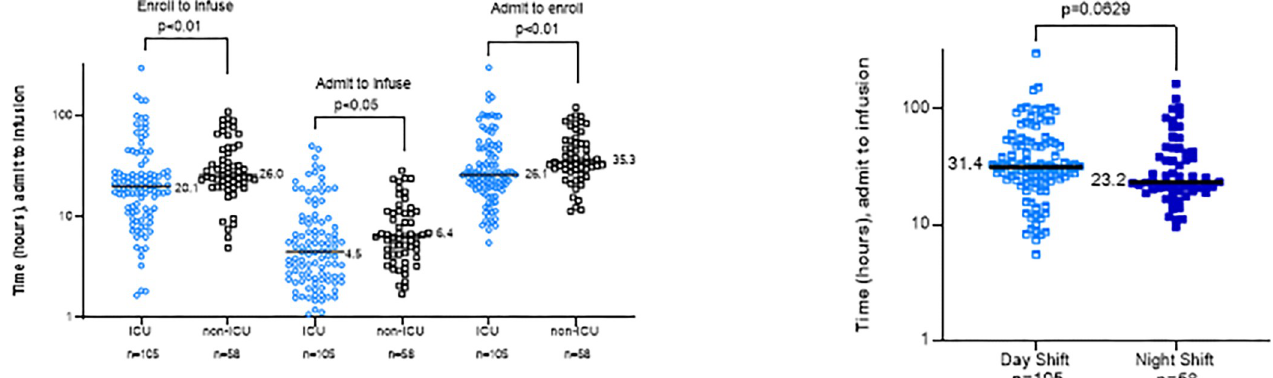
Fig 3. Time to CCP infusion comparisons. (A). Time from admission to enrollment, enrollment to CCP infusion and admission to CCP infusion via the EAP at UNCMC in the ICU (blue open circles) versus the non-ICU (black open squares). (B) Time from admission to CCP infusion via the EAP at UNCMC for those admitted during the day shift (7am-7pm) (middle blue open squares) versus the night shift (7pm-7am) (dark blue squares). Medians are reported. P values obtained via a non-parametric Mann-Whitney U test.